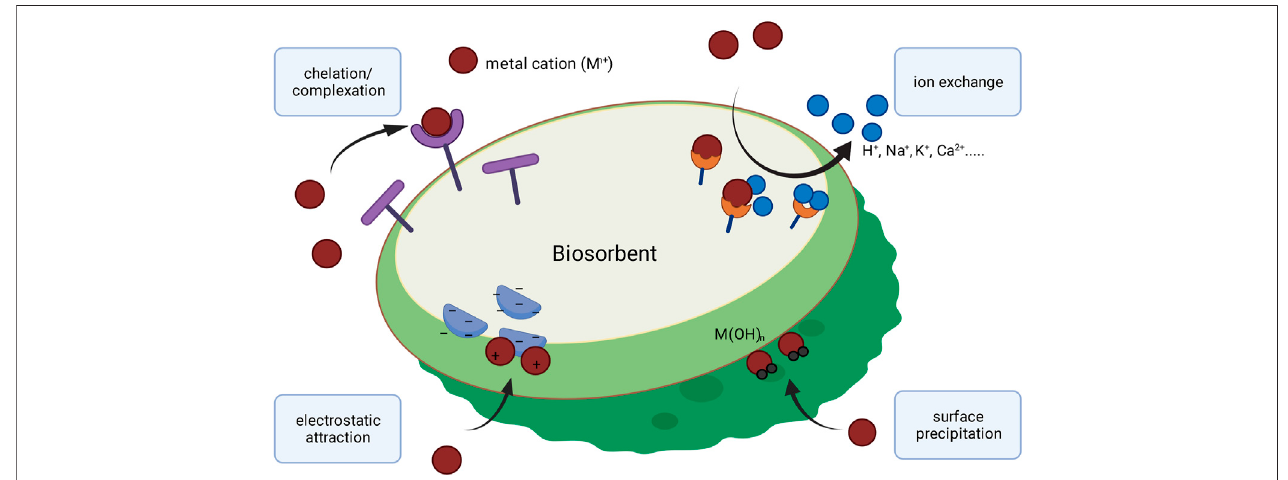
FIGURE 1 | Schematic overview of proposed mechanisms for biosorption of